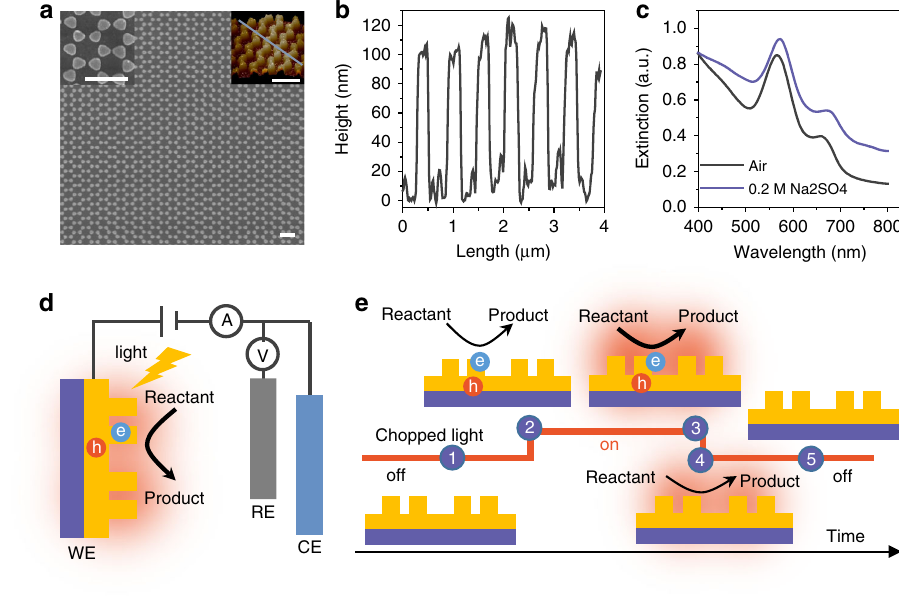
Fig. 1 Structures of the as-prepared plasmonic electrode and photoelectrochemical system. a SEM and AFM images. b The height pro fi le of the as-prepared Au nanoelectrode array along the gray line in AFM image of a . c The UV-Vis distinction spectrum detected by the specular re fl ection mode in air and in 0.2 M sodium sulfate solution. d Schematic of the three-electrode electrochemical system used in the experiments, including working electrode (WE), counter electrode (CE) and reference electrode (RE). e Schematic of photoelectrochemical characterization under the chopped light. The scale bars in a are 1 μ m. The area of the gold nanoelectrode array is 0.8 cm 2 . The numbers in e represent different